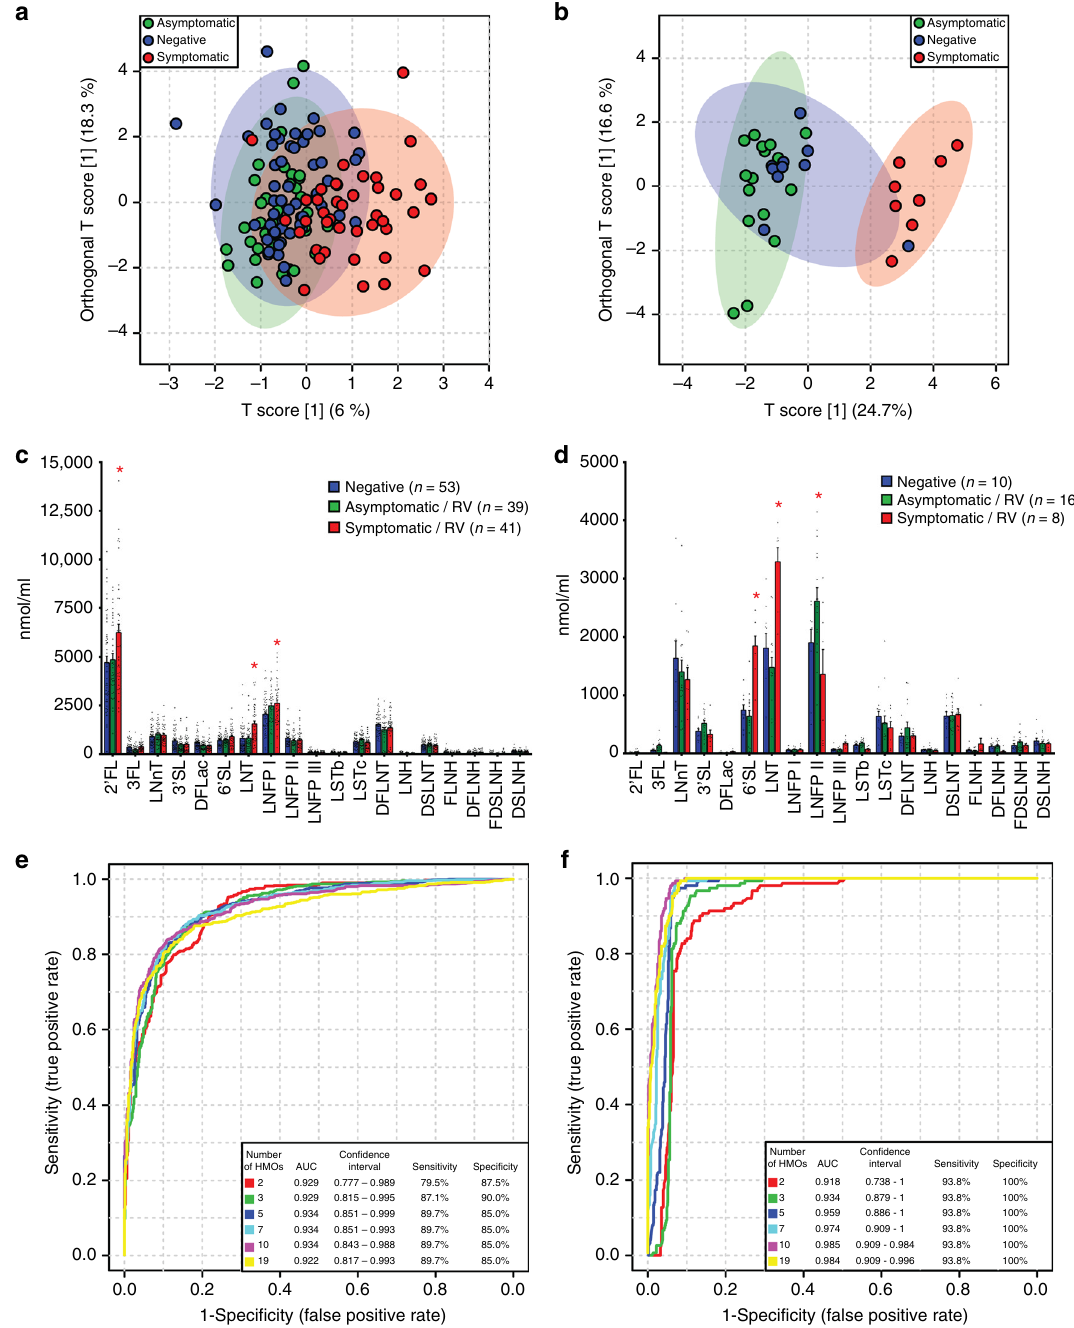
Fig. 2 Speci fi c HMOs are associated with symptomatic rotavirus infection. Orthogonal partial least squares-discriminatory analysis (OPLS-DA) within a secretors only and b non-secretors only show that the HMO pro fi le of breast milk from mothers in the symptomatic rotavirus group are distinct from the asymptomatic and rotavirus negative groups. This distinction is mediated by differences in the levels of LNT, 2 ’ FL, and LNFP I in secretors ( c ) and by LNT, 6 ’ SL, and LNFP II in non-secretors ( d ). Bar graphs represent average levels of each HMO in nmol/ml with error bars indicating standard error of the mean. p value <0.05 (analysis of variance with Dunnett ’ s post hoc test) was considered statistically signi fi cant (asterisk (*)). The HMO pro fi le of breast milk was predictive of symptomatic rotavirus infections as seen by receiver operating characteristic (ROC) curves generated by linear support vector machine (SVM) classi fi cation showing the area under the curve (AUC) with different numbers of HMOs included in the model within secretors ( e ) and non- secretors ( f symptomatic infections based on maternal secretor status since (SVM) classi fi cation. Since the rotavirus-negative and asympto- LNT is present in milk from all mothers. matic rotavirus-positive groups were highly comparable overall, To determine how predictive individual HMOs are for these groups were combined to create a binary grouping for SVM symptomatic rotavirus infection, receiver operating characteristic analysis. ROCs curves plotted for the top 2, 3, 5, 7, 10, and 19 (ROC) curves were generated by linear support vector machine HMOs showed that the area under the curve (AUC) with only 2